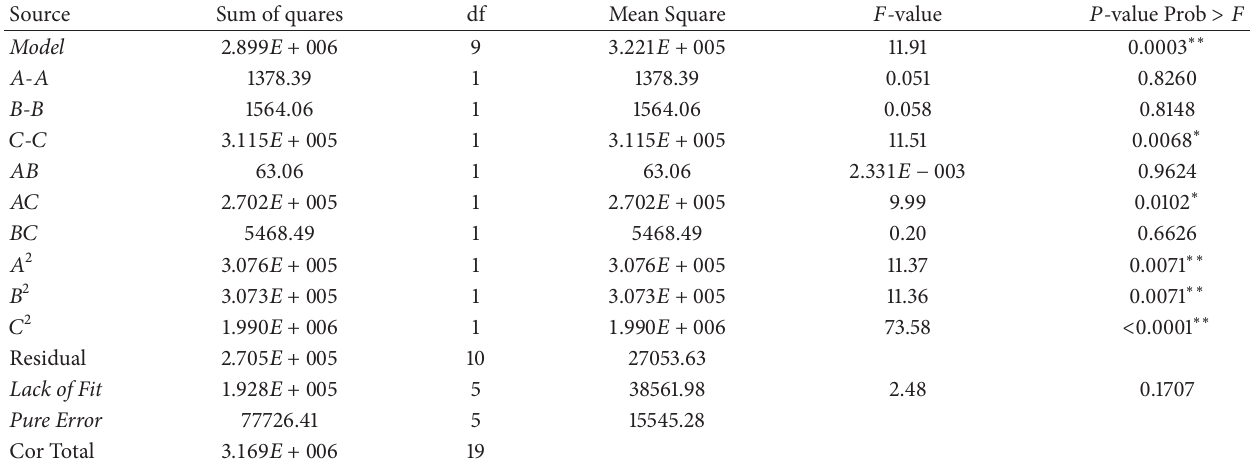
Table 9: ANOVA for response surface quadratic polynomial model for amino acid, nucleoside analogue, and